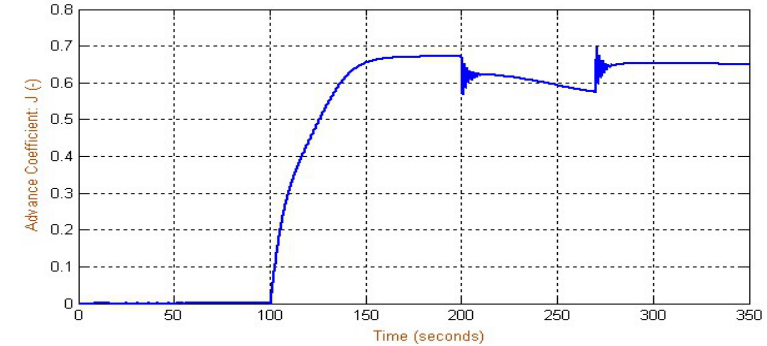
Figure 29. Advance coefficient versus time.